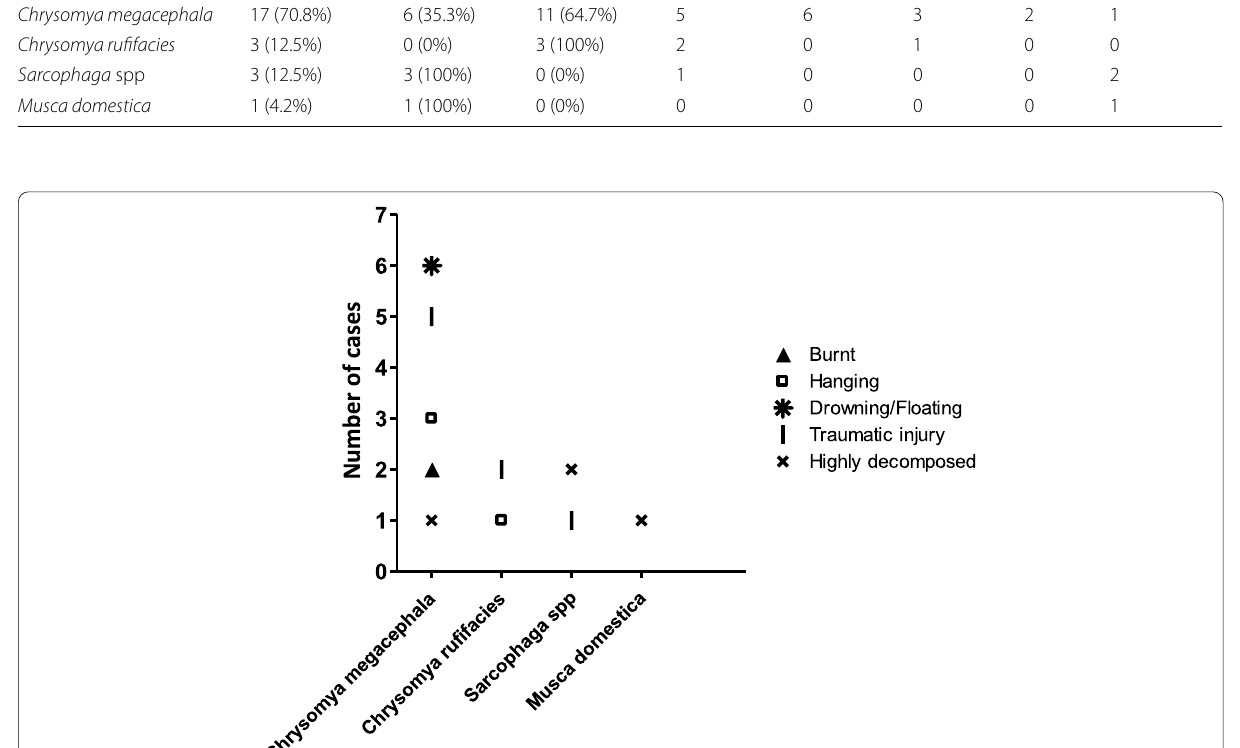
Fig. 8 Frequency of occurrence of necrophagous fly species of forensic importance on the corpses of different pre-autopsy